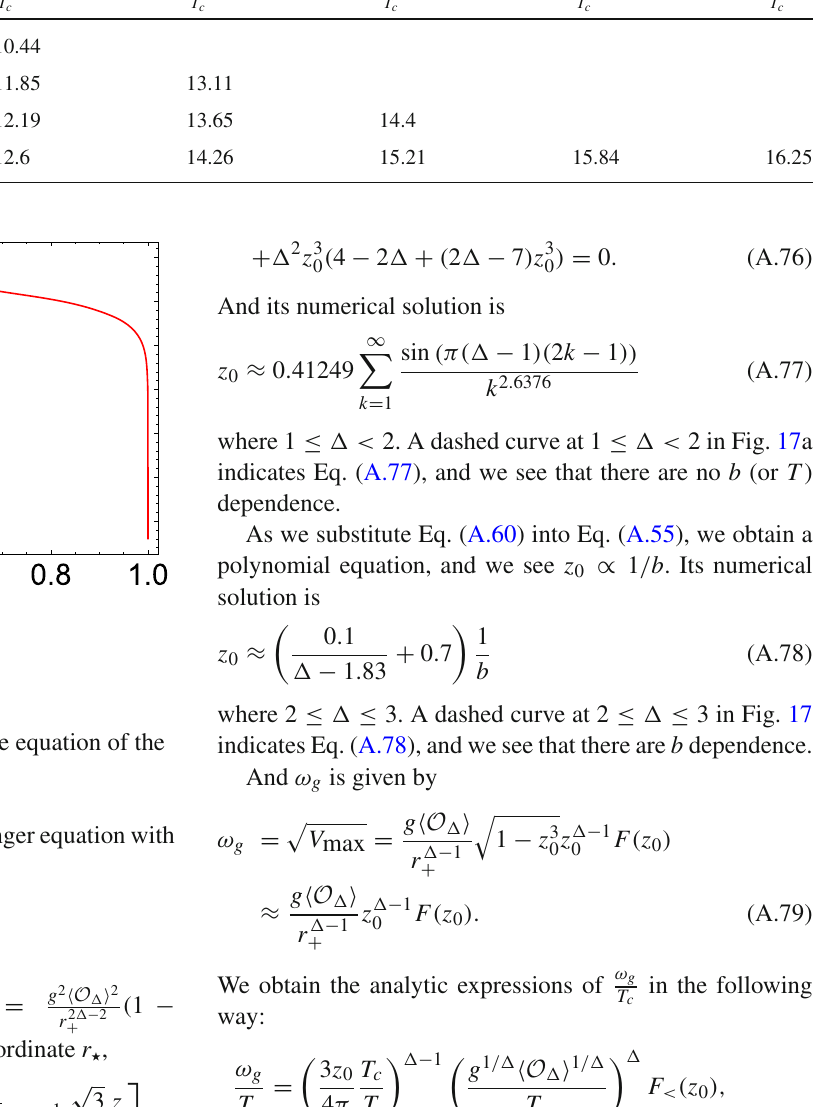
by applying Mathematica T c ω 4 T c